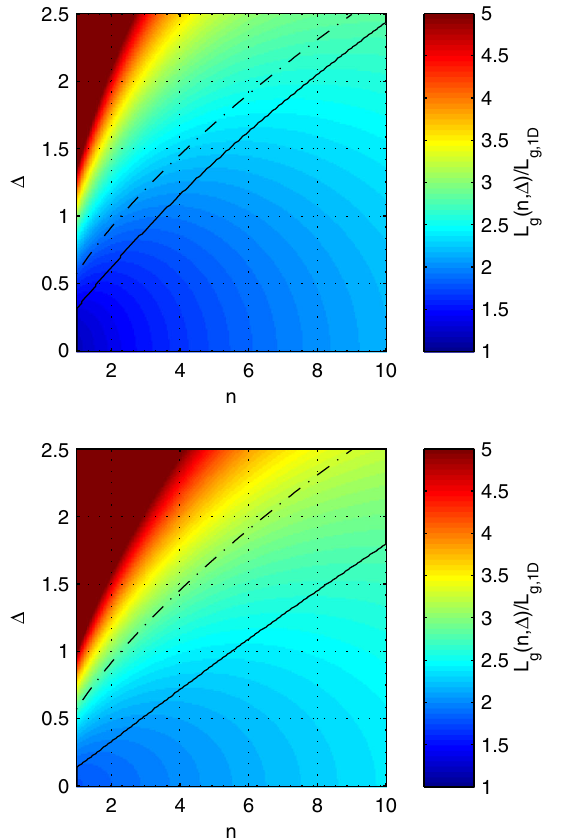
ð n; (cid:2) Þ =L FIG. 4. Normalized gain length L as a function of g g; 1D the stretching factor n and the normalized energy spread (cid:2) for an ¼ 3 (top) and =L ideal, initial normalized bunch length (cid:3) z c; 1D ¼ 1 (bottom). The solid black line marks the ideal =L (cid:3) z c; 1D stretching factor resulting in the shortest gain length for each initial normalized energy spread; the dashed line marks the ideal stretching factor expected without bunch length correction. Dark red are regions with a normalized gain length of 5 and